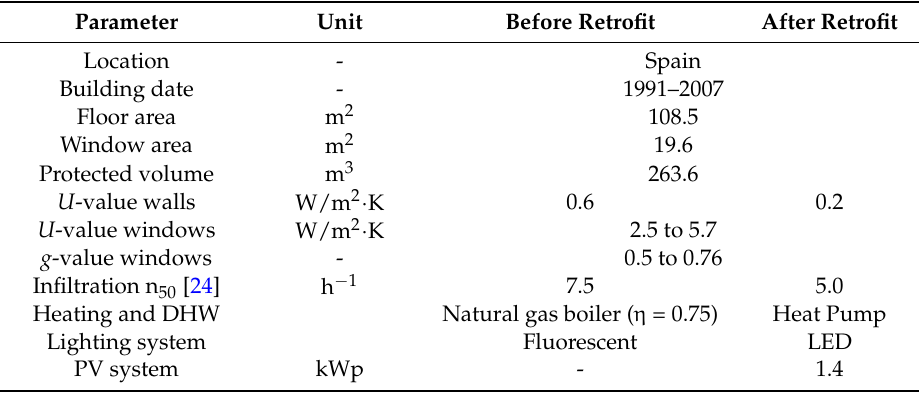
Figure 1. 3D model, photo, and floor plan of the study case building. Table 1. Main characteristics of the building before and after the retrofit.